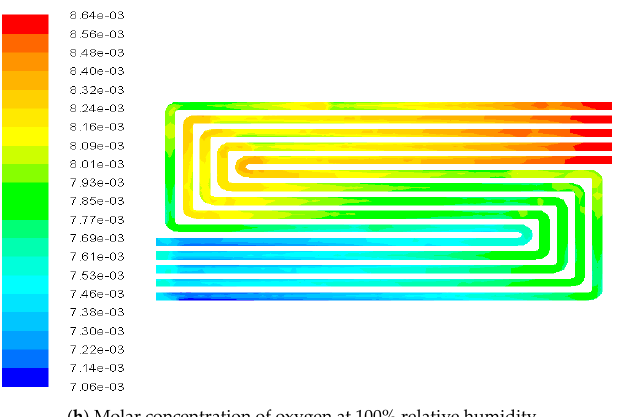
Figure 7. Contours of fuel cell species distribution.